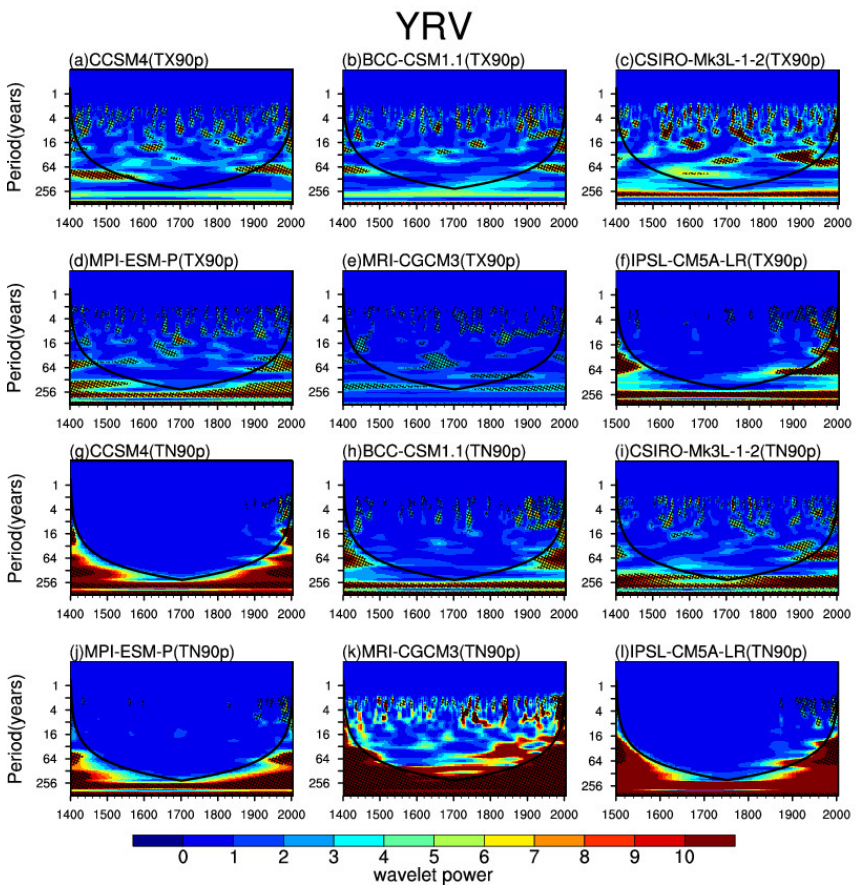
Figure 6. Wavelet analyses of TX90p and TN90p in YRV from 1400–2005 CE. ( a – f ) Simulated TX90p by six models. ( g – l ) Simulated TN90p by six models. The shaded area shows the periods with confidence levels higher than 95% and the cone of influence is shown as the black line. Table 3. Trend in summer TX90p and TN90p during the last 600 years in NC and YRV. Model